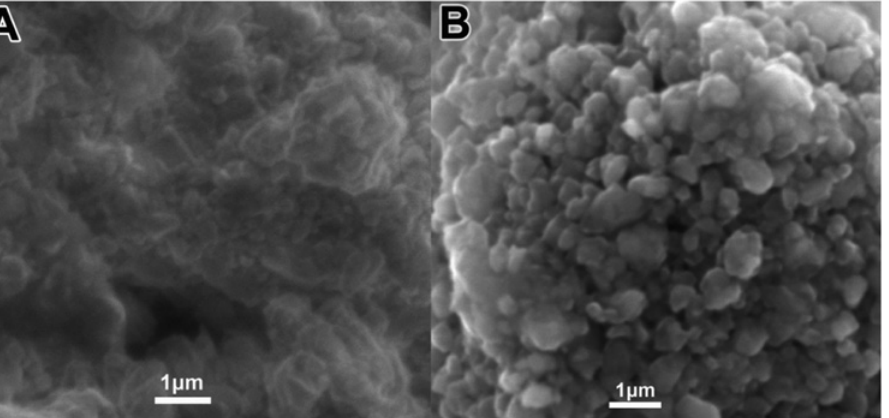
particles: (A) As-received MgB 2